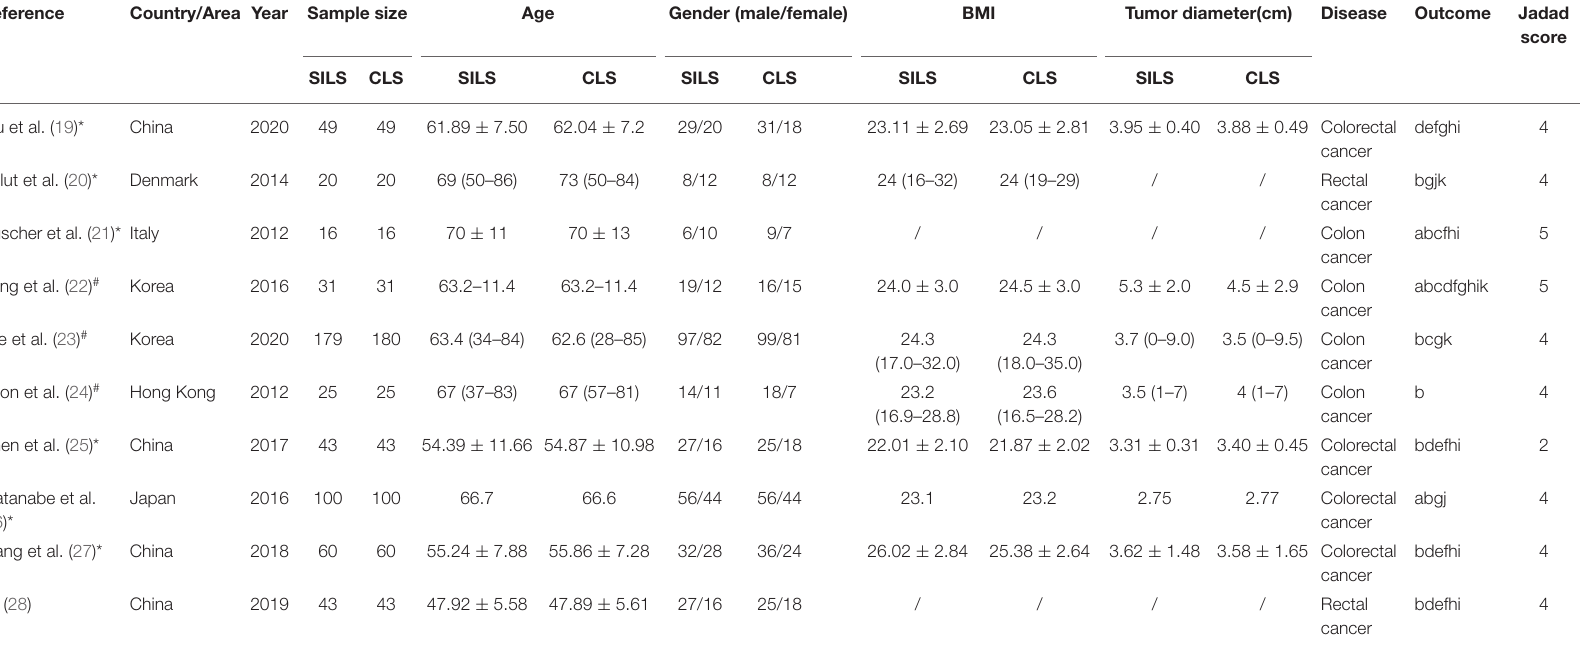
TABLE 2 | Main characteristics of the selected studies.